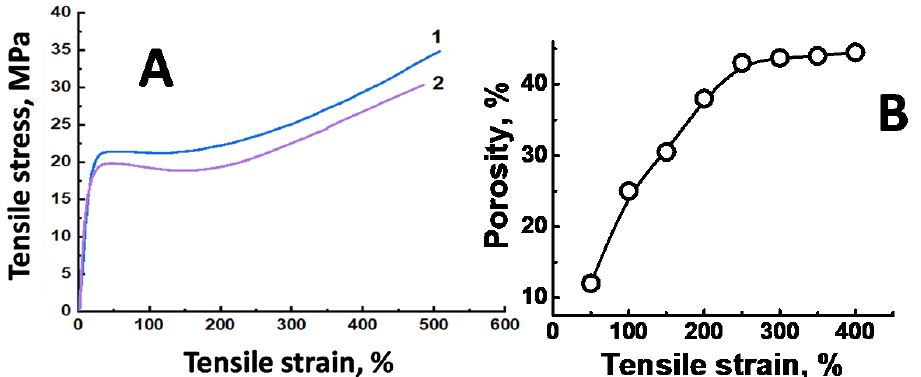
Figure 2. ( A ) Stress-strain curves illustrating the tensile drawing of the UHMWPE films in air (1) and in n -heptane and in the oil-in-water emulsions of n -heptane and water with a high water content of 95% (2) and ( B ) the plot describing the development of porosity of the UHMWPE samples with tensile strain upon tensile drawing in n -heptane and in the oil-in-water emulsions of n -heptane and water with a high water content (95% of